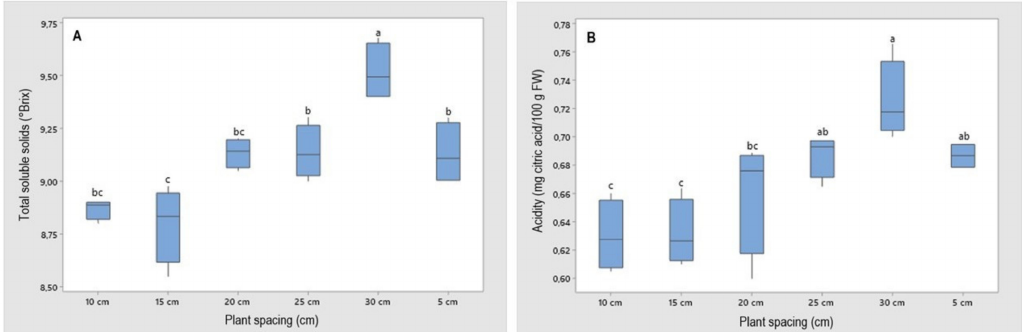
Figure 6. The response of total soluble solids value ( A ) and acidity ( B ) of strawberry plants cv. ‘Pircinque’ in different spacing between plants with average of the 2018/2019 and 2019/2020 harvests. For each spacing, the different letters indicate significant differences ( p ≤